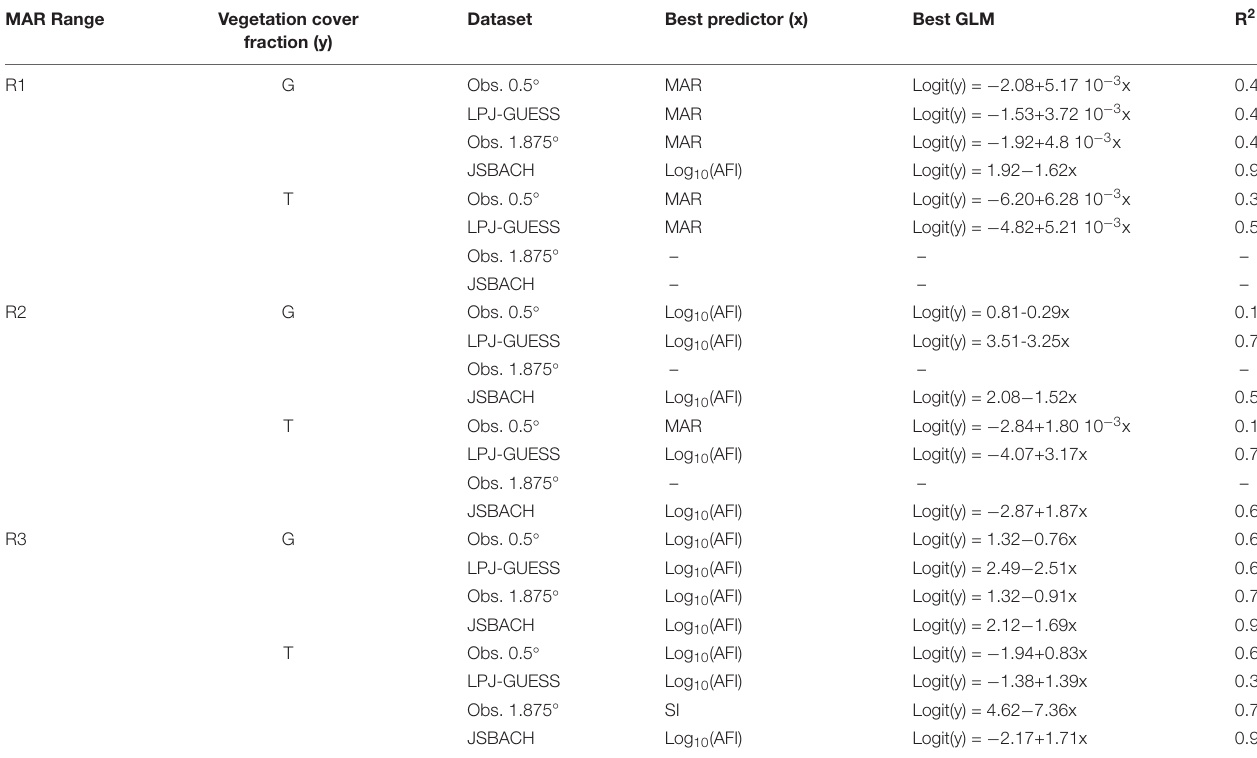
TABLE 2 | Results of the GLM analyses in the three mean annual rainfall (MAR) ranges: low MAR (R1, MAR ≤ 630 mm year − 1 ), intermediate MAR (R2, 630 mm year − 1 < MAR < 1200 mm year − 1 ) and high MAR (R3, MAR ≥ 1200 mm year − 1 ) for obs. 0.5 ◦ , LPJ-GUESS, obs. 1.875 ◦ and JSBACH datasets. MAR